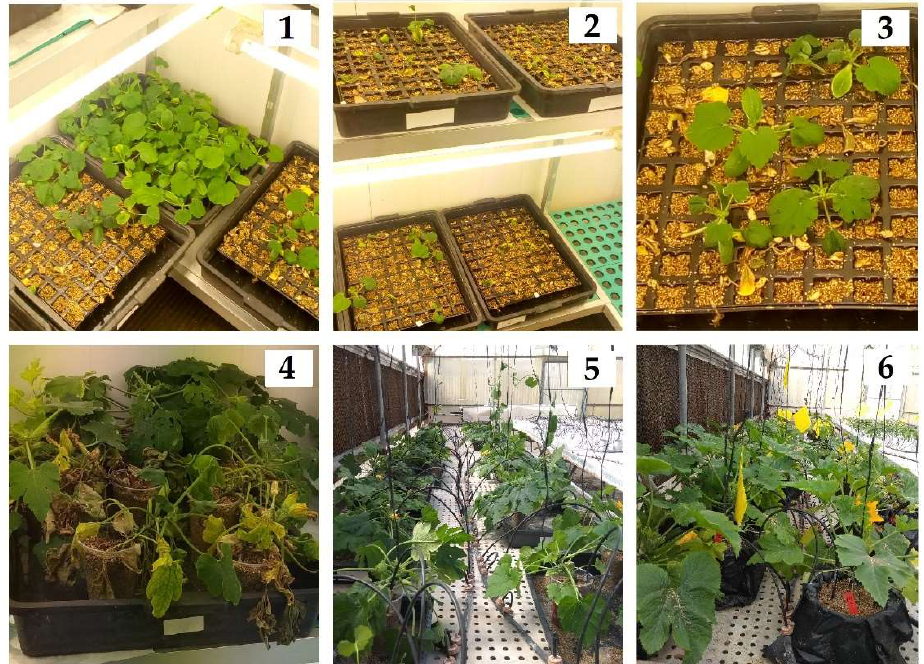
Figure 1. Tolerance screenings in the mutant population of MUCU-16. Screening with seedlings 14 days post-inoculation (dpi) ( 1 – 3 ): control tray (center) without inoculation ( 1 ); Fusarium solani f. sp. cucurbitae (left) and Phytophthora capsici (right) inoculated trays ( 2 ); individuals showing tolerance ( 3 ). Screening with selected plants ( 4 – 6 ): plant symptomatology 21 dpi—surviving individuals were moved to a greenhouse after 34 dpi and reinoculated ( 5 ); surviving plant growth until 97 dpi for fruit production ( 6 ).